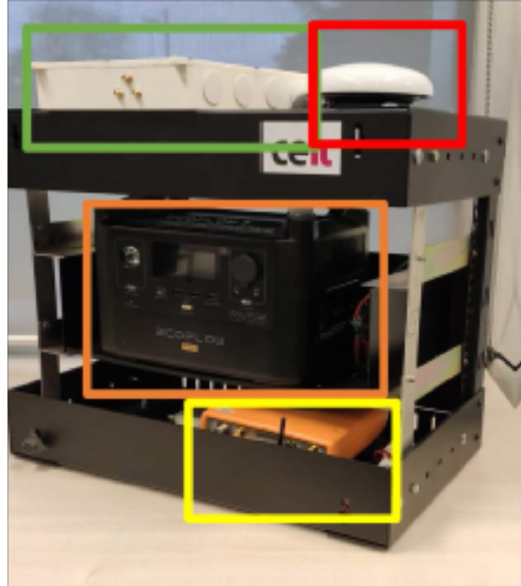
Figure 6. Employed measurement system (red: GNSS antenna; green: navigation system; orange: power supply; yellow: ground truth generating system).